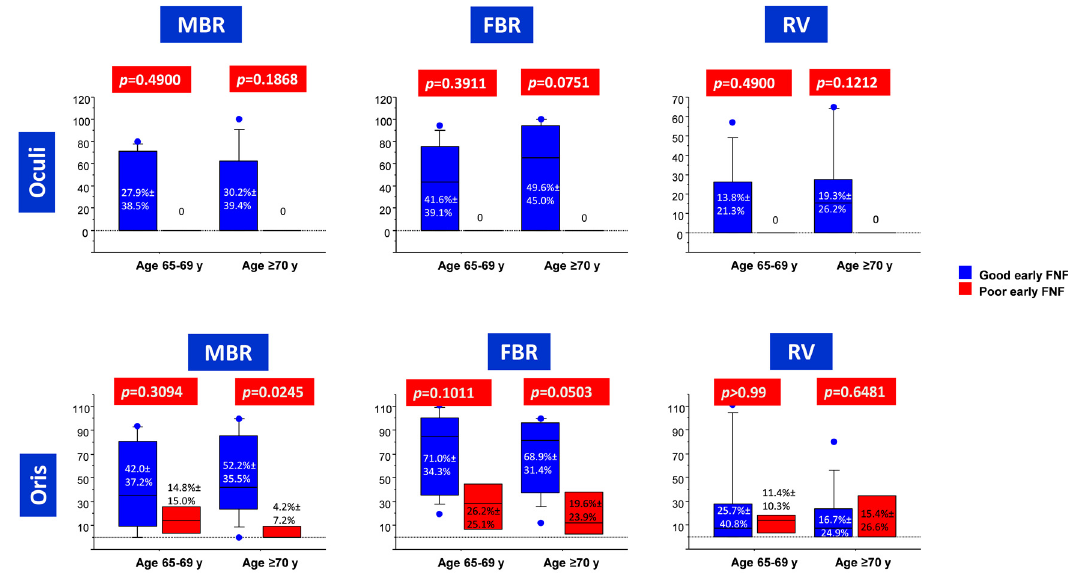
operative FNF. Figure 3. Box plots depicting corticobulbar FMEP indices depending on age and late post-operative